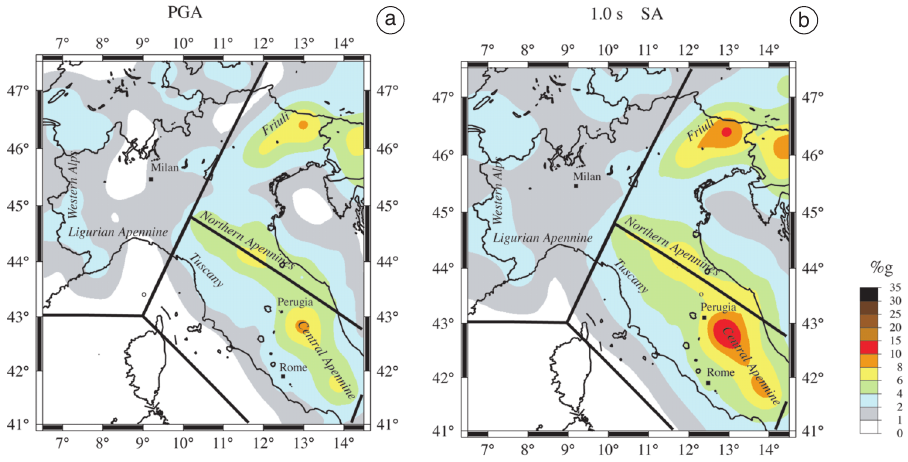
Fig. 7a,b. Parameter 95% confidence band map in Northern and Central Italy for b -value, a) PGA and b) 1-Hz spectral acceleration